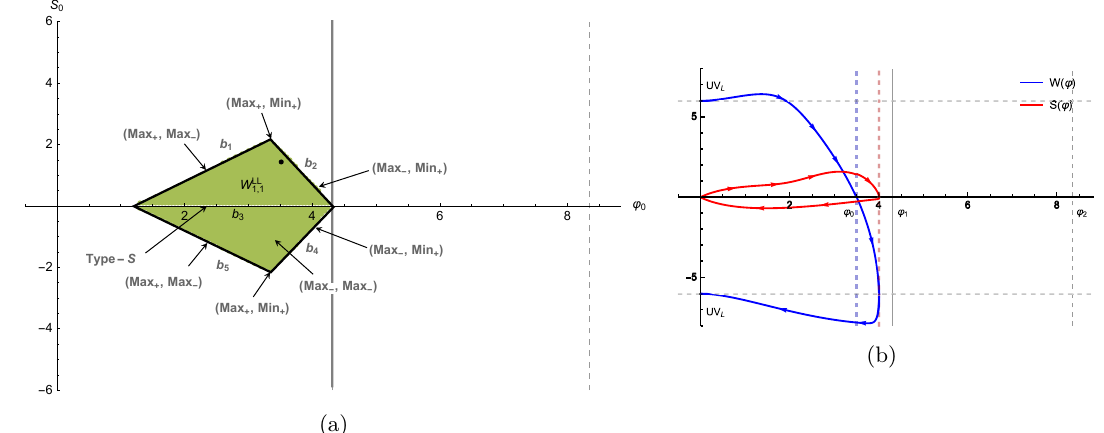
Figure 16 . (a): the space of the W LL ∈ ( Max − , Max − ) solutions. For each b 1 to b 5 boundary 1 , 1 and corner of this region, we have different types of solutions. (b): the blue and red curves describe a flow (represented by the black dot of diagram (a)) that connects the top UV boundary to the L bottom UV at the same fixed point. Here the blue and red dashed lines show the location of the L A-bounce and ϕ -bounce points